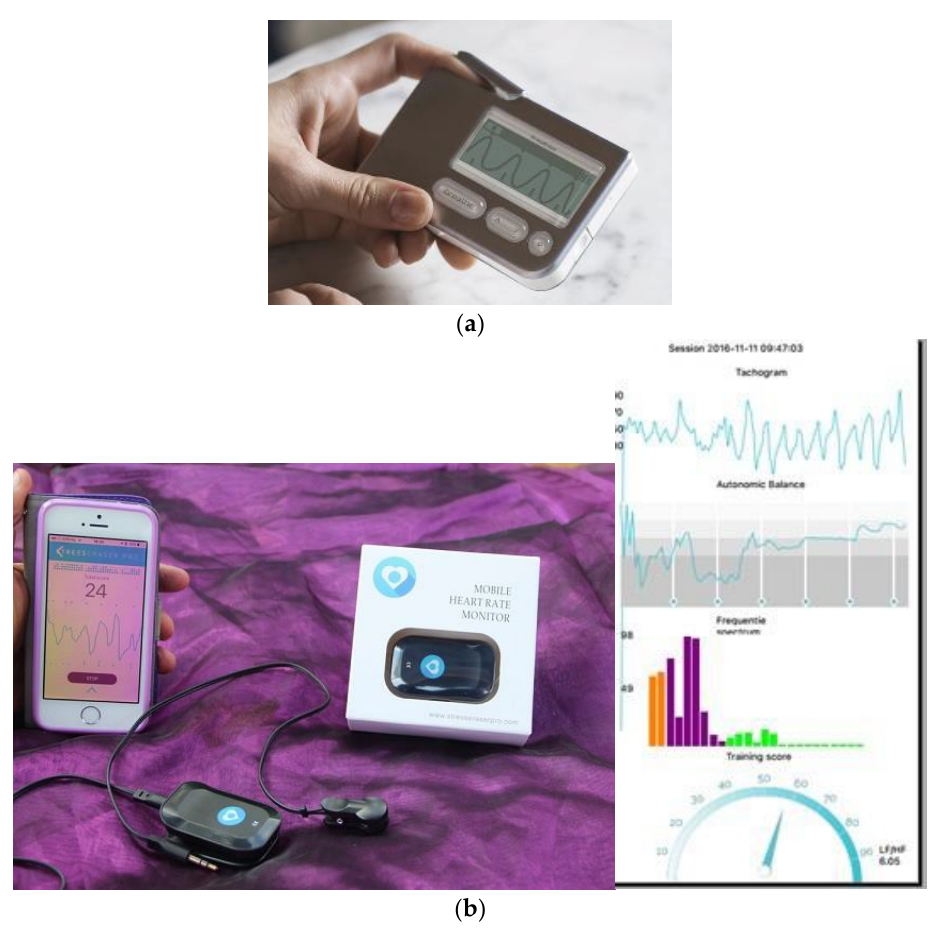
Figure 4. ( a ) StressEraser. ( b ) StressEraser Pro.